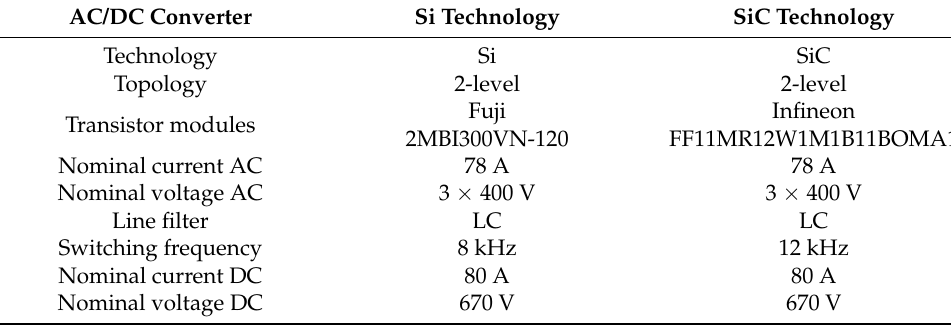
Figure 11. Block scheme of charger prototypes analyzed in experimental study: ( a ) unidirectional charger with a 2-level AC/DC converter and a DC/DC converter composed of single-phase bridge and a full bridge diode rectifier in Si technology; ( b ) bidirectional charger with 2-level AC/DC converter and DC/DC converter composed of a dual active bridge (DAB) in SiC technology. The parameters of the AC/DC converters for the analyzed versions of the two chargers are listed in Table 4, while the parameters of DC/DC converters are given in Table 5. Both chargers are made in the same housing. Table 4. Parameters of the AC/DC converter used in the analyzed EV chargers.